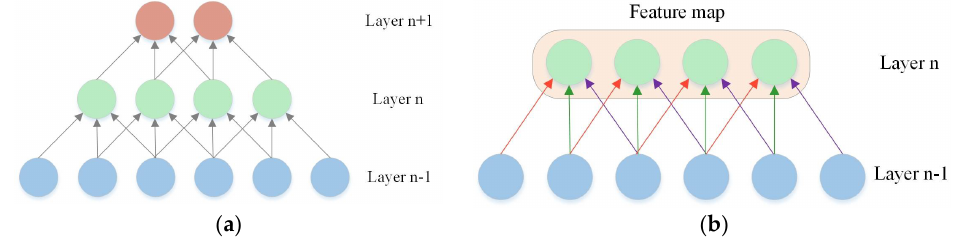
Figure 1. Illustration of sparse connectivity and parameter sharing for CNN: ( a ) sparse connectivity; and ( b ) parameter sharing.